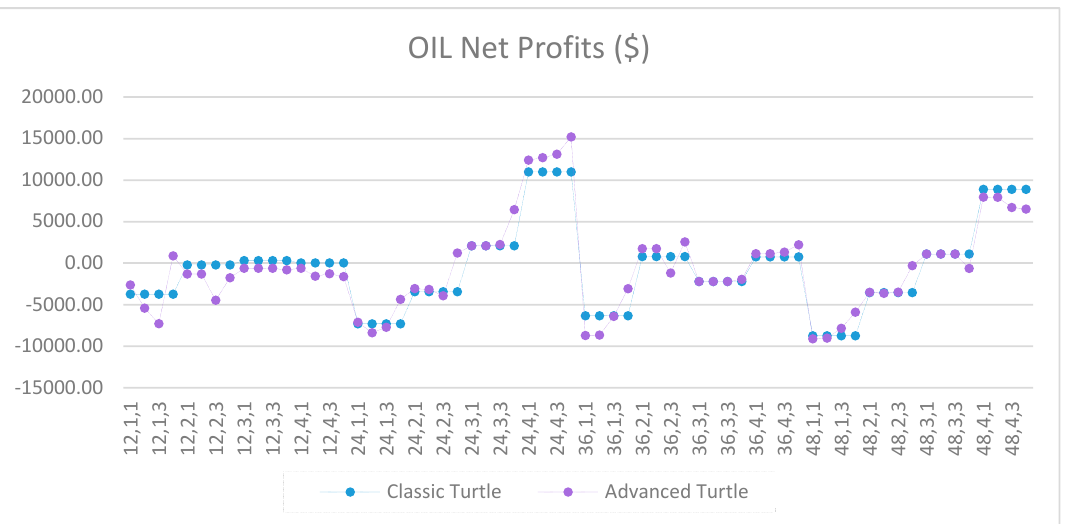
Figure A45. Net profits of OIL between the classic and the advanced Turtle systems for every combination of N, X, Y for the slow parameters (80, 160).